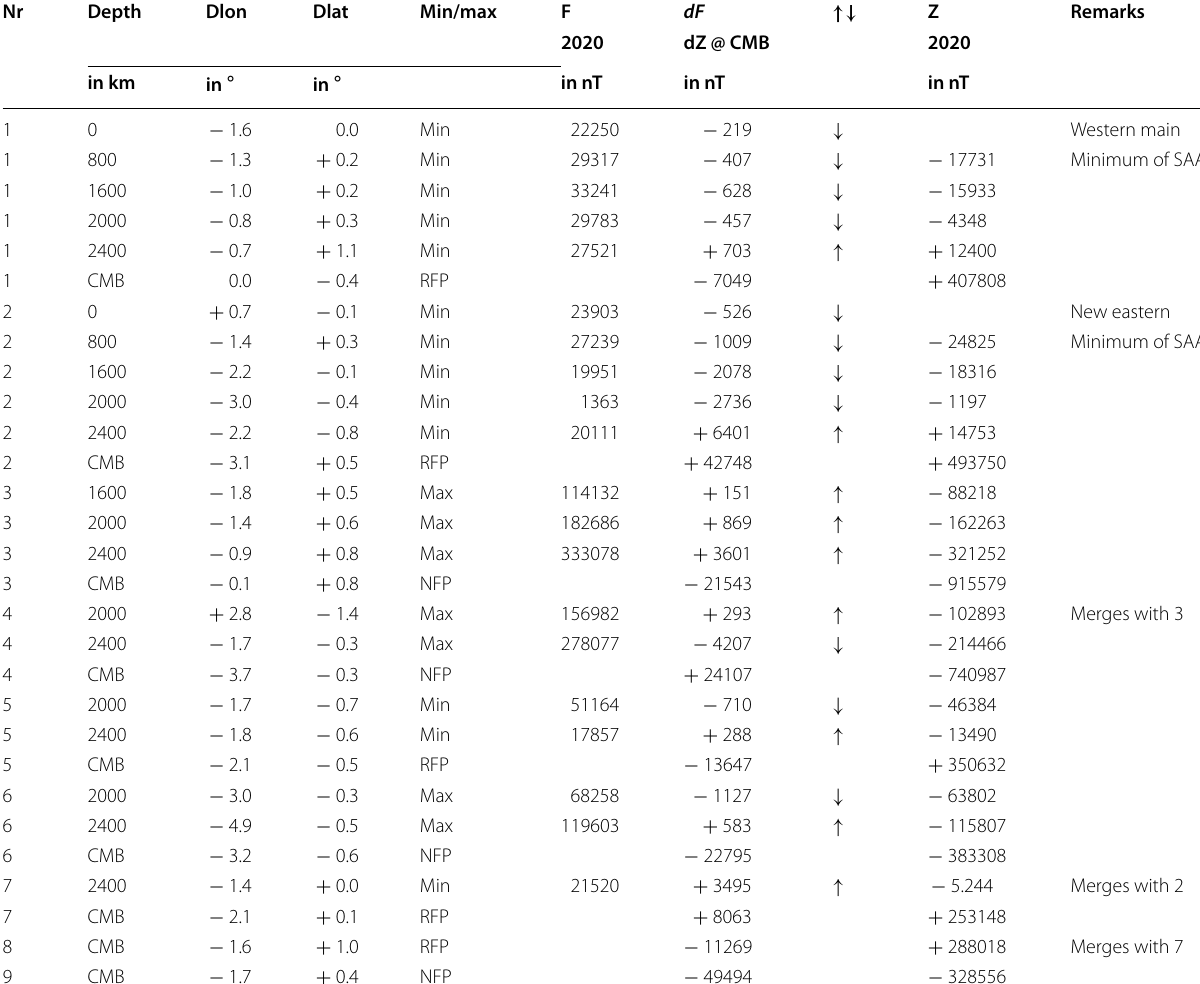
Table 3 Information about extrema in F and Z labelled in Fig. 11 and Additional file 2: Figure S1